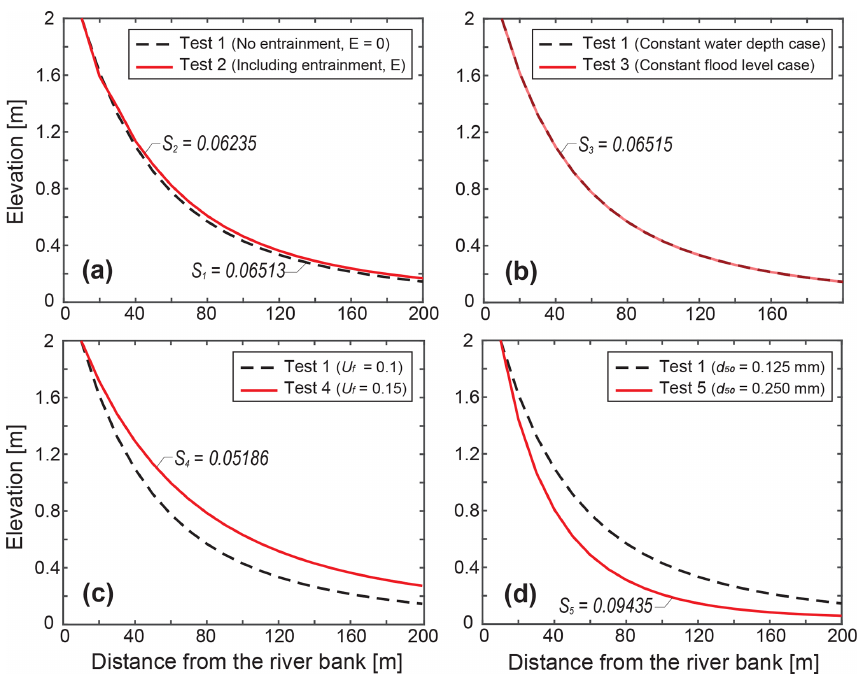
Figure 3. Levee surface profiles taken at the end of each model. The dashed black line represents the results of Test 1 and the red lines are other test